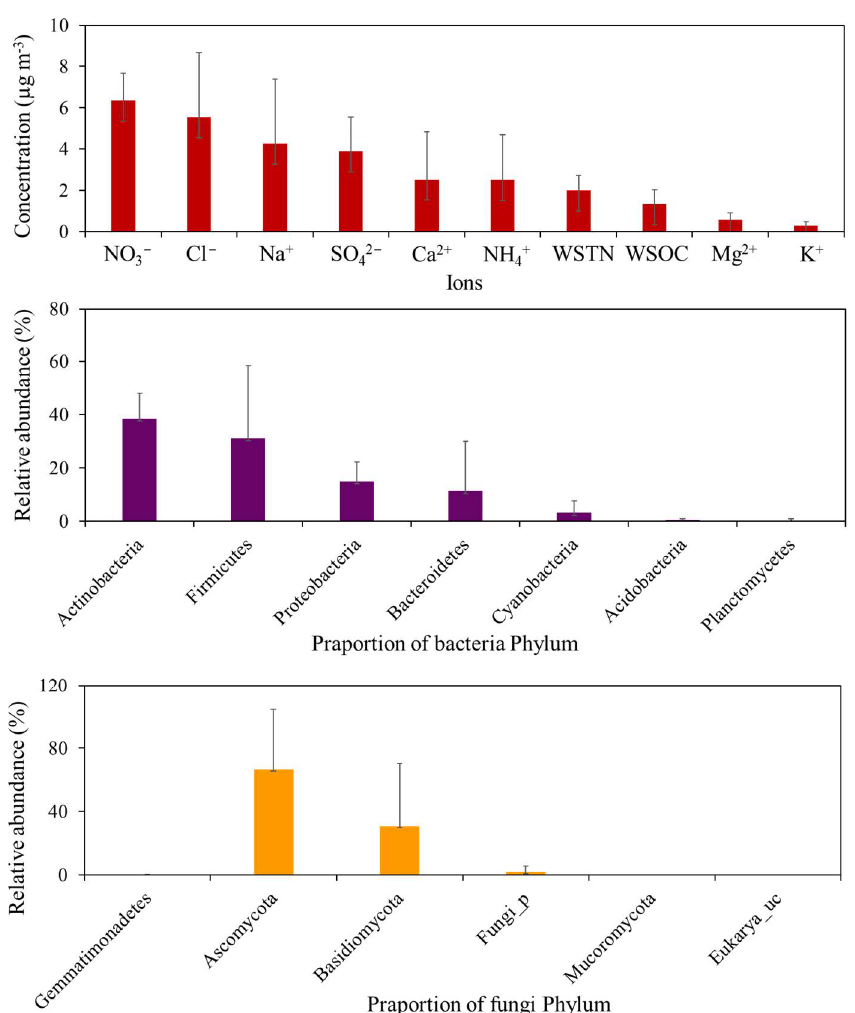
Figure 5. Mean concentrations of the chemical components and proportions of bacterial and fungal phyla in the fresh snowfall samples collected from Daejeon, the Republic of Korea. The red bars in the graph show the concentration of ions, while the purple and orange bars show the relative abundance of the bacterial and fungal phyla, respectively.